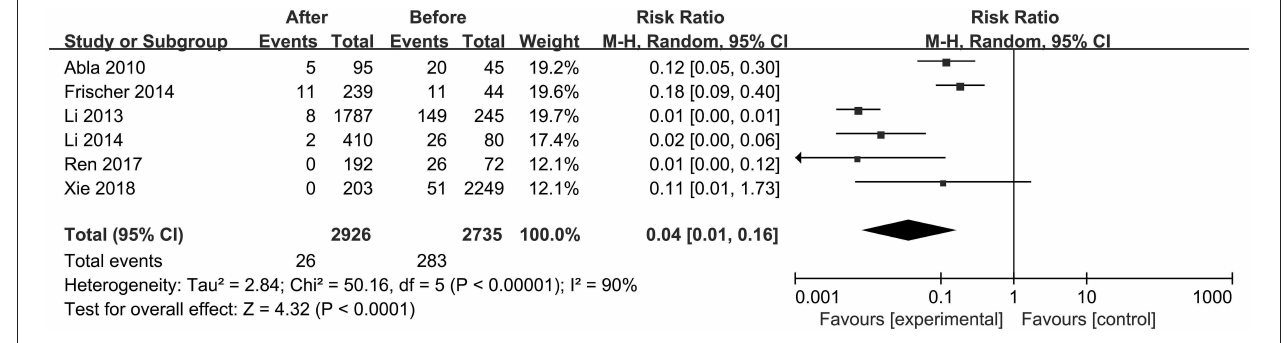
FIGURE 2 | Forest plot of neurosurgery studies comparing the RRs.